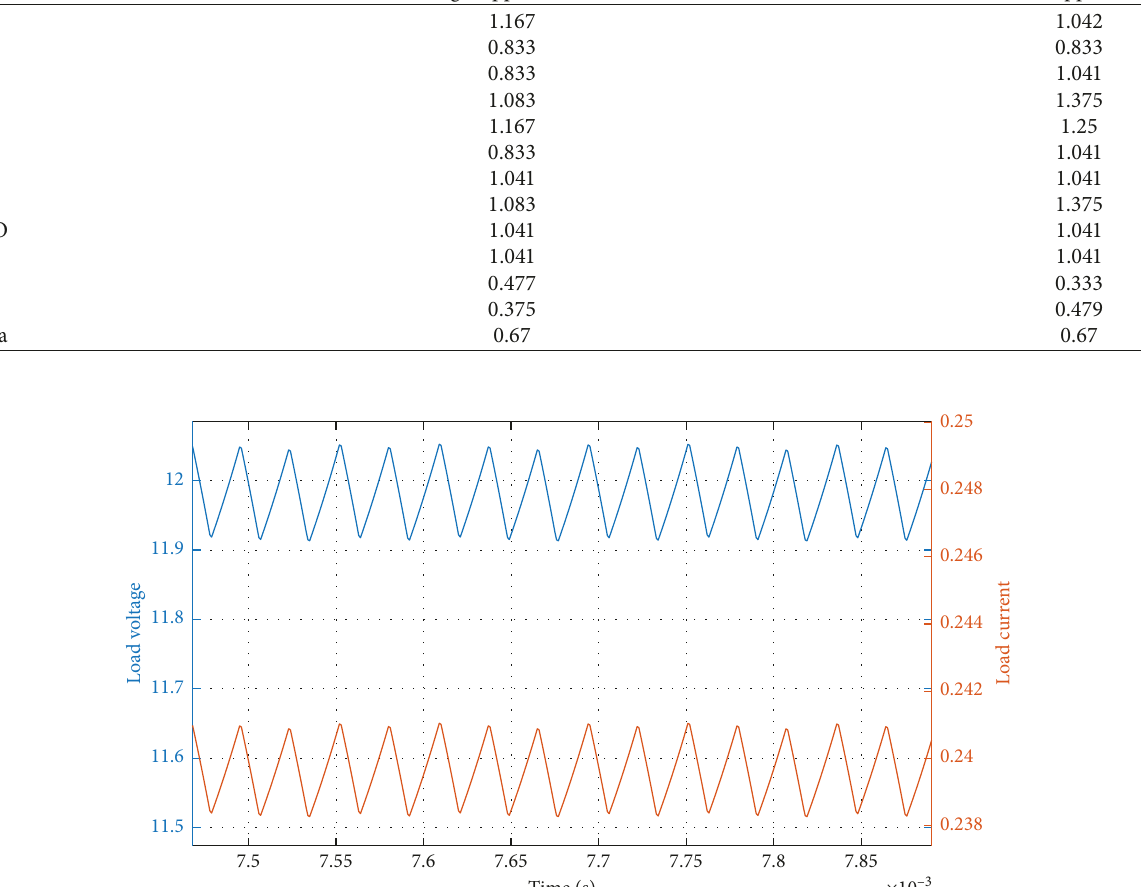
Figure 8: Plot for output current and voltage ripple for varying input voltage case using flower pollination algorithm-tuned QFTcontroller.